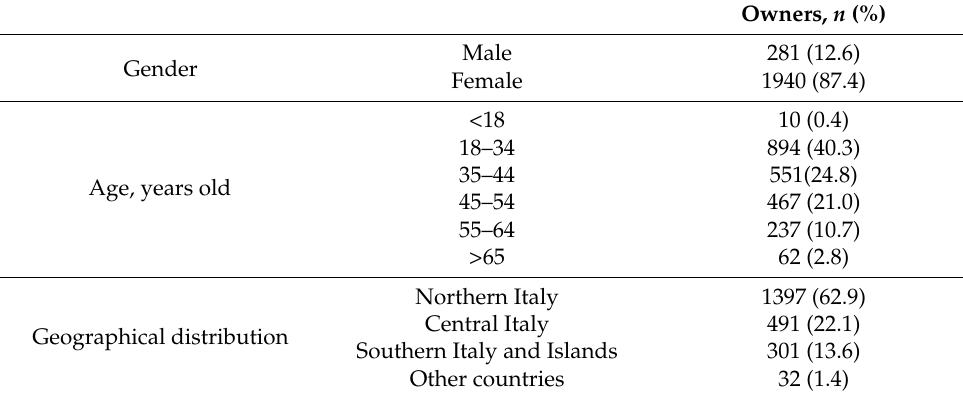
Table 1. Demographics of survey respondents ( n =